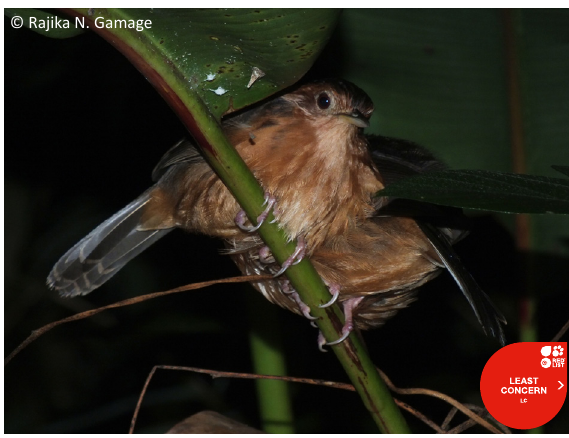
Image 13. Dull Blue Flycatcher Eumyias sordidus